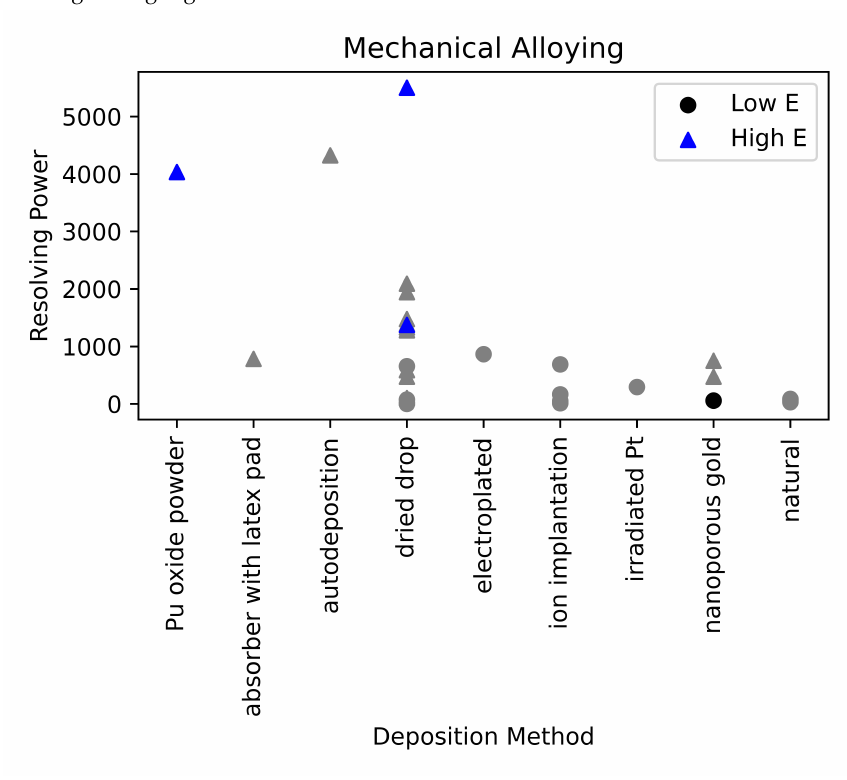
Figure 8. Detector resolving power as a function of deposition method. The effects of diffusion welding are highlighted here.